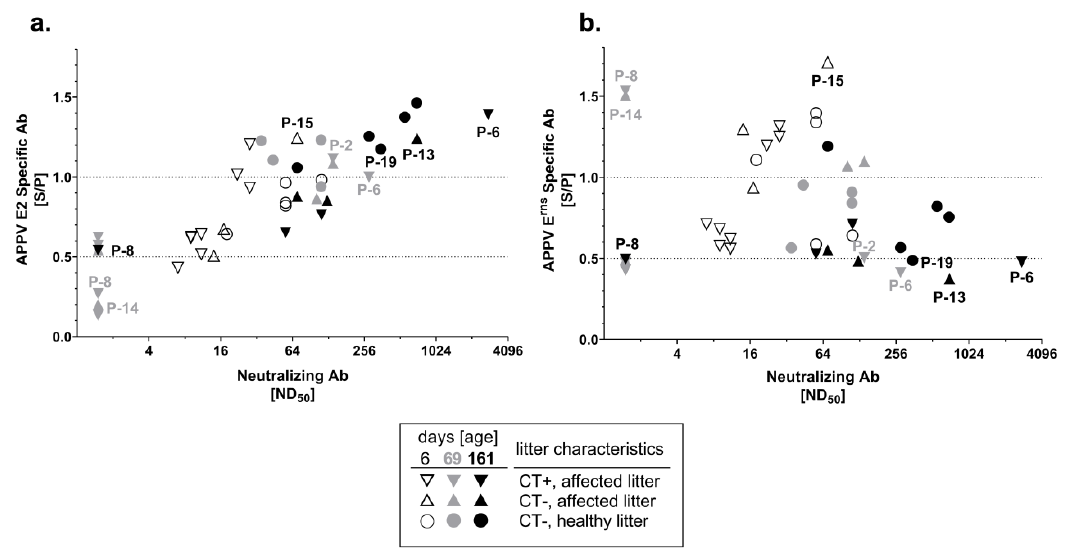
Figure 4. Reactivity of the sera against the APPV E2 and E rns envelope proteins and virus neutralizing capacity. Symbols indicate the health and infection status of the piglets. Shades of the symbols indicate the age of piglets. ( a ) Correlation of APPV E2 antibody ELISA ( y axis) and VNT results ( x axis). ( b ) Correlation of APPV E rns antibody ELISA ( y axis) and VNT results ( x axis). Individual animals indicated in the figures were described in detail within the results section. P-2, P-6, P-8, P-13, P-14 and P-15 are individually presented in Figure